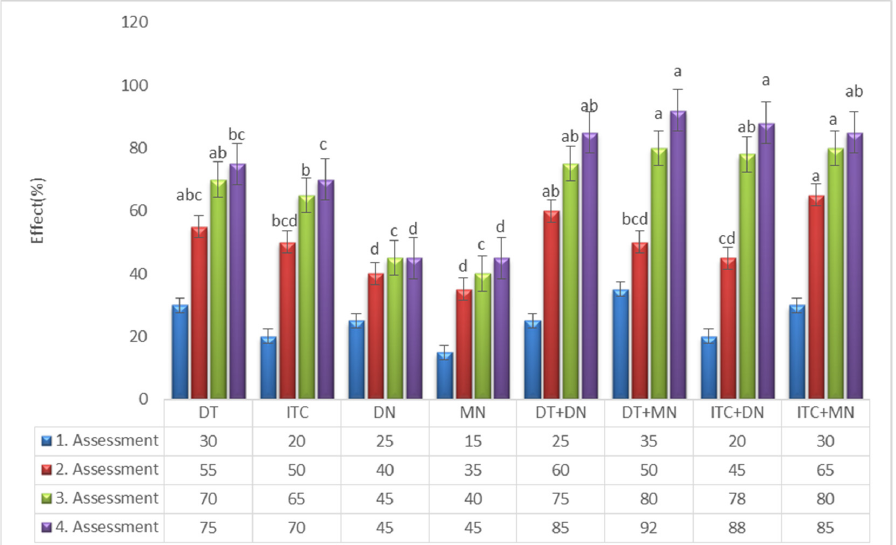
Figure 2. Assessment intervals after herbicide applications. Each assessment was compared within itself. According to the variance analysis, the effects of treatments were not statistically significant after first assessment. The differences between the means with the same letter are not significant at the 0.05 level.